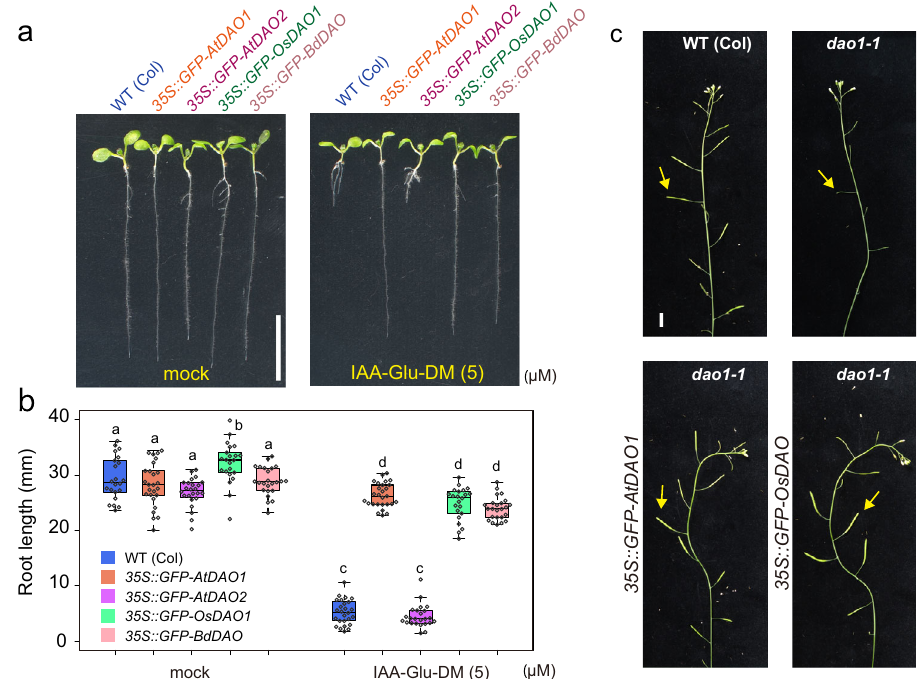
Fig. 4 Monocot O. sativa and B. distachyon DAO enzymes inactivate IAA-amino acid conjugates. a , b Primary root lengths of 7-d-old DAO- overexpressing Arabidopsis GFP-AtDAO1 and GFP-AtDAO2 and rice GFP-OsDAO and B. distachyon GFP-BdDAO lines were measured. The seedlings were grown for 7 days on vertical GM plates with or without IAA-Glu-DM. Scale bar, 10 mm. The different letters represent statistical signi fi cance at P < 0.001 (Tukey ’ s HSD test, n = 22 – 27). c Phenotypes of primary in fl orescences from 35-d-old WT, dao1-1 , and complemented lines ( GFP-AtDAO1 and GFP-OsDAO ). At least fi ve plants from each line were examined. Scale bar, 10 mm. This experiment was repeated three times